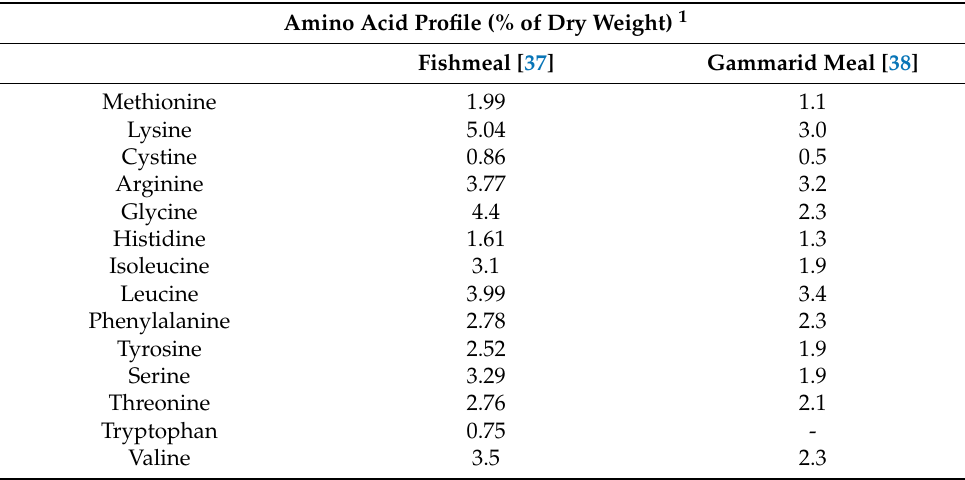
Table 2. Amino acid profile of fishmeal and gammarid meal (amphipod